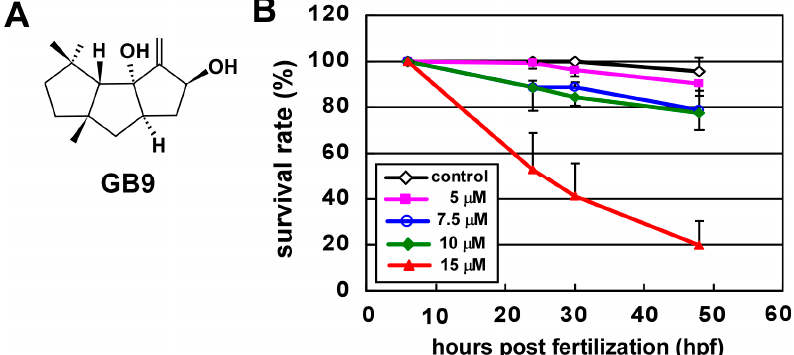
Figure 1. Chemical structures of capnellene (GB9) and toxic effects of GB9 on zebrafish. ( A ) Capnellene (GB9: 4,4,6a-trimethyl-3-methylene-decahydro-cyclopenta[ e ]pentalene-2,3a-diol) has a molecular weight of 204 g/mol. ( B ) Wild-type zebrafish embryos ( n = 75, 80, 50, and 68) were treated with various concentrations of GB9 (0, 5, 7.5, 10, and 15 μ M) at 6 hours post-fertilization (hpf), with